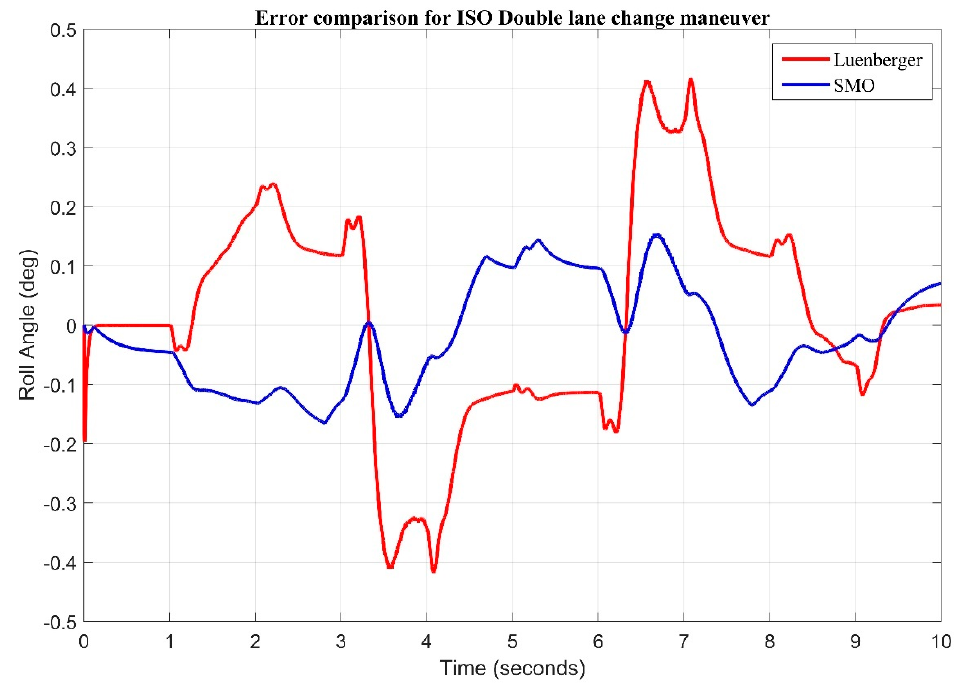
Figure 11. Error comparison of observers during double lane change input .